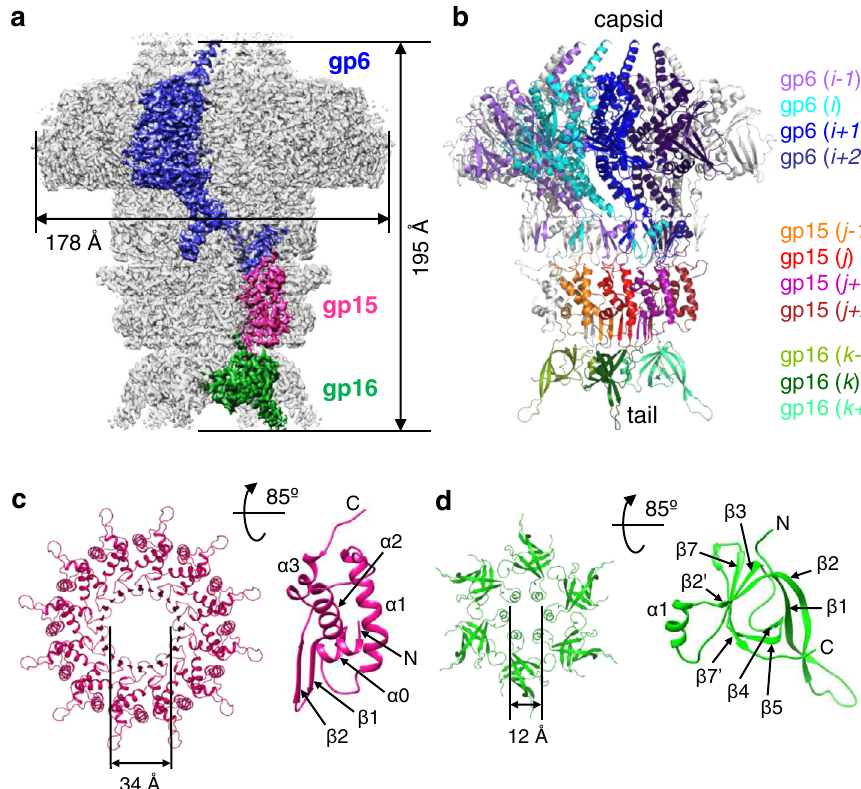
Fig. 1 | Structure ofthe SPP1 connector (gp6 12 gp15 12 gp16 6 ) complex. a CryoEM map of the SPP1 connector. One subunit of each gp6, gp15, and gp16 oligomer is showninblue,magenta,andgreen,respectively. b Atomicmodeloftheconnector. For clarity, only the front half of the oligomer is shown. Four subunits of gp6 are displayed in purple, cyan, blue and dark blue. Four subunits of gp15 are in orange, red, magenta, and brown. Three copies of gp16 are in variations of green. Subunit